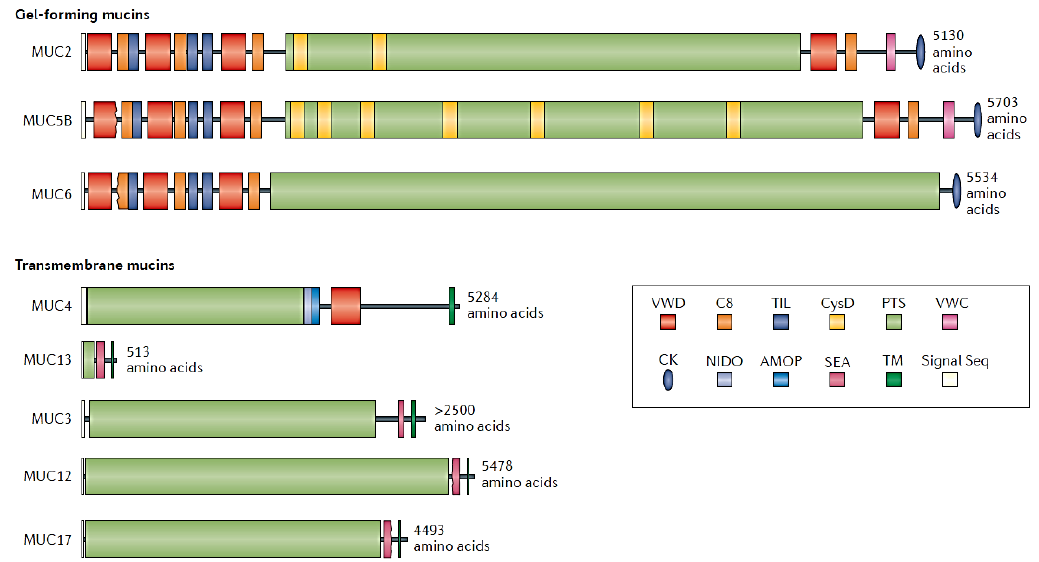
Figure 2. The domain structure of mucins. VWD: Von Wiellebrand D-domain, C8: conserved cysteine rich domain, TIL: trypsin inhibitor-like cystein-rich domain, CysD: domain rich in cystein